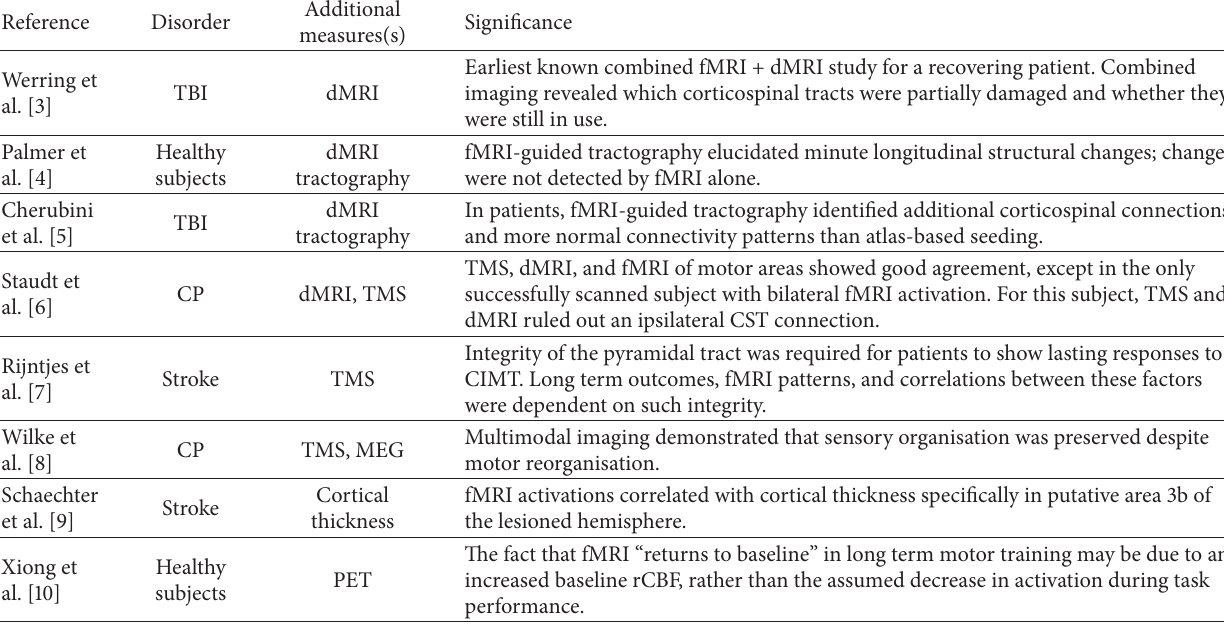
Table 1: Example of multimodal studies of brain injury and